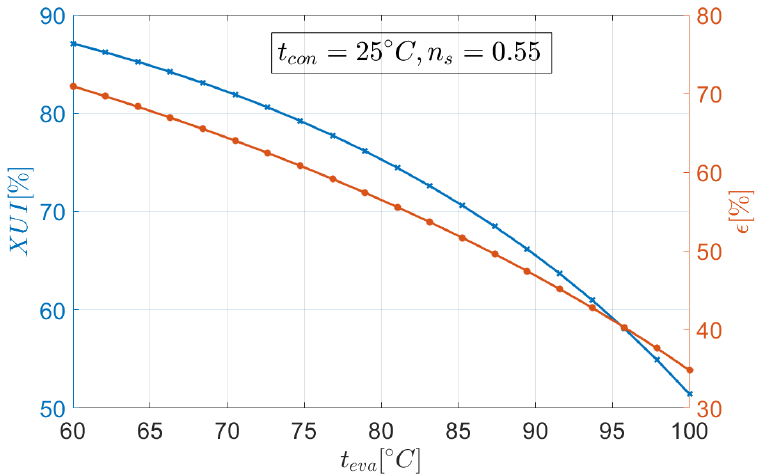
ff ectiveness index ε as functions of evaporation temperature t Figure 9. XUI and effectiveness index ε as functions of evaporation temperature t eva. Figure 9. XUI and e